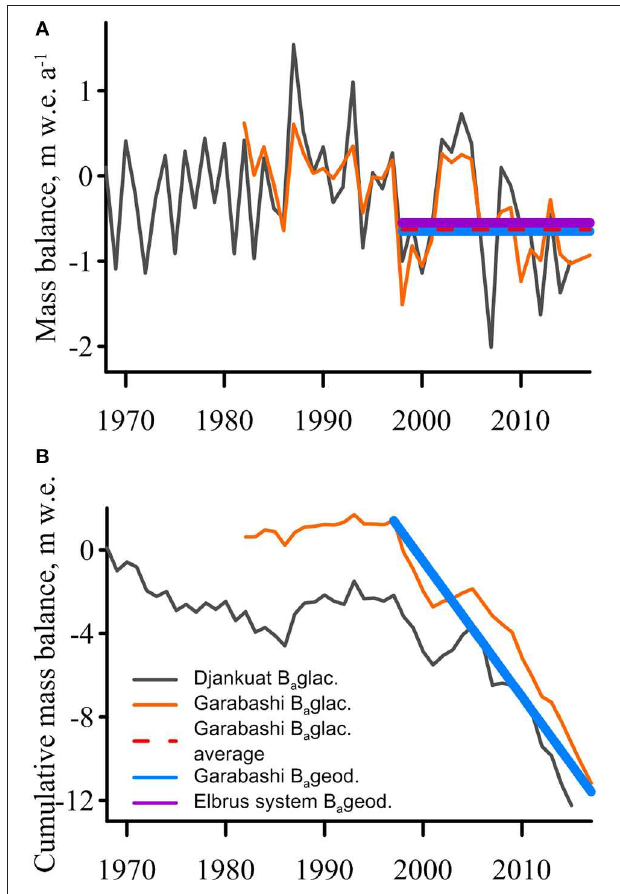
FIGURE 7 | (A) Glacier-wide annual mass balance and (B) cumulative mass balance of the Garabashi and Djankuat glaciers. The geodetic mass balance calculated for Garabashi glacier and the entire Elbrus system as a result of this work is shown. Line thickness corresponds to the error of geodetic estimation.